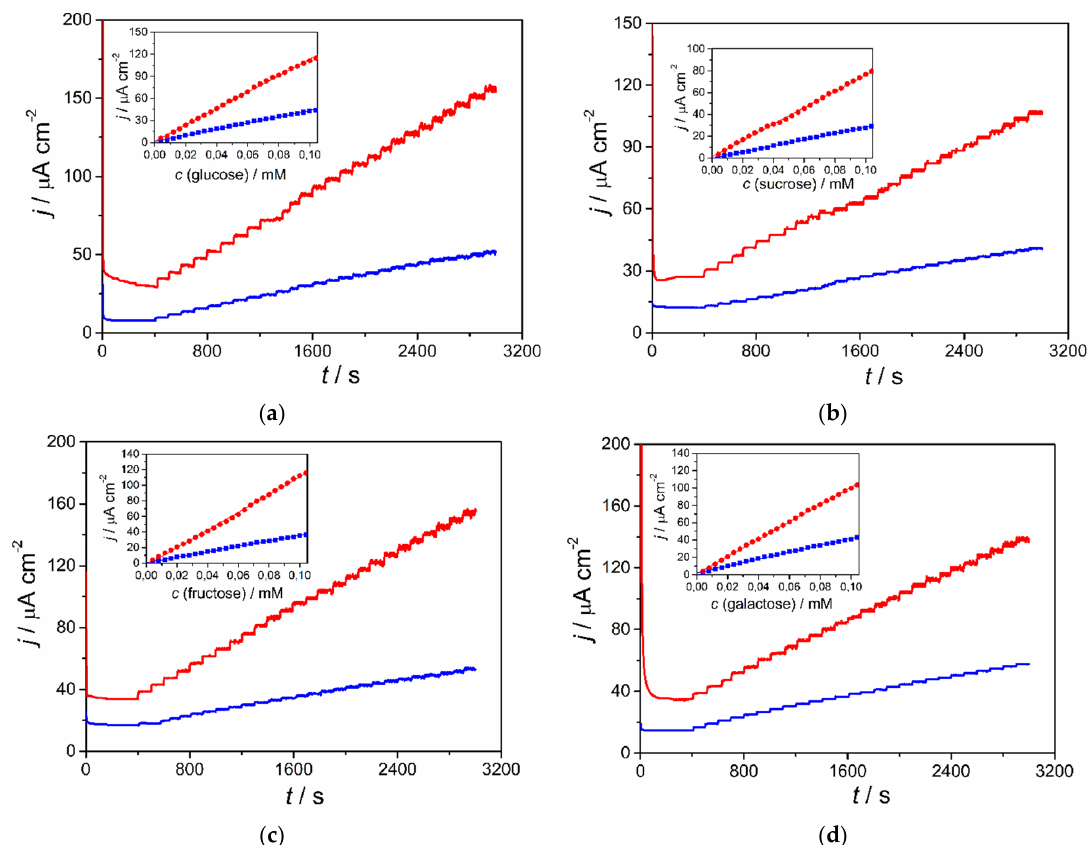
Figure 3. Hydrodynamic amperometry of saccharides within concentration range 4 × 10 − 6 –1 × 10 − 4 mol L − 1 saccharides in 0.1 mol L − 1 NaOH at +0.6 V vs. Ag/AgCl using CuFE (blue line) and pCuFE (red line): ( a ) glucose; ( b ) sucrose; ( c ) fructose; ( d ) galactose. Each experiment was performed on a newly prepared sensor.